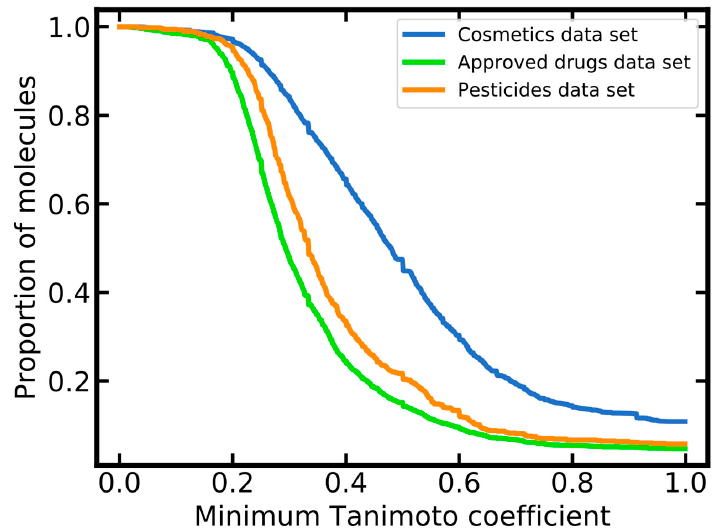
Figure 2. Molecular similarity between each compound of the reference data sets (i.e., cosmetics, approved drugs and pesticides data sets) and its nearest neighbor in the merged local lymph node assay (LLNA) data set (similarity quantified as Tanimoto coefficient based on Morgan2 fingerprints with a length of 2048 bits).